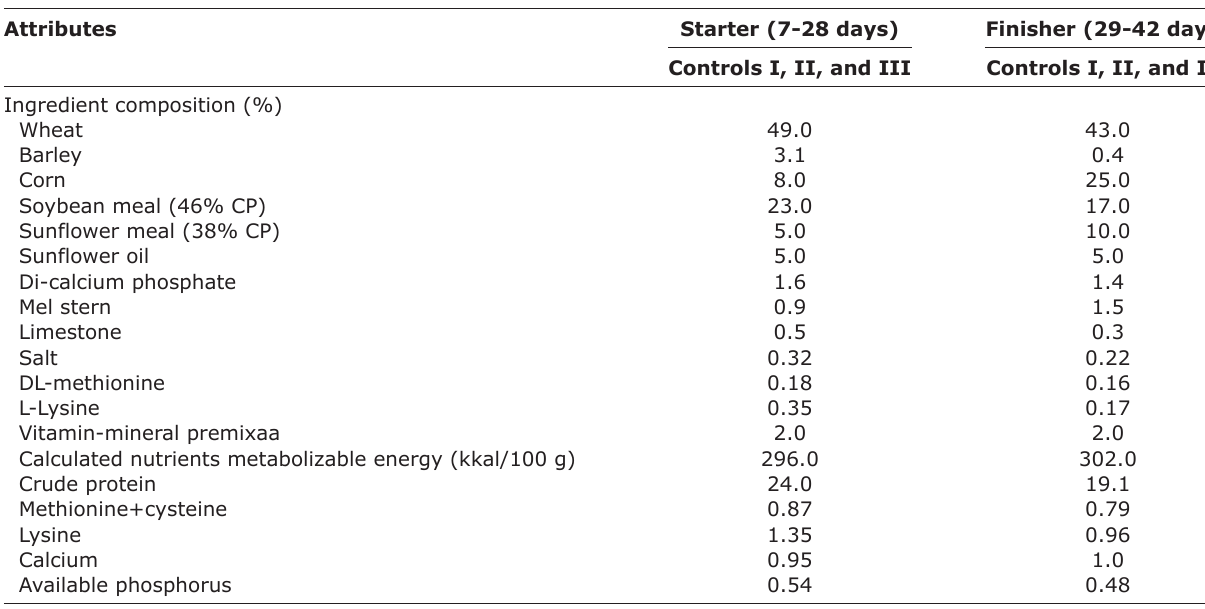
Table-1: Ingredients and nutrient level of basal diets.